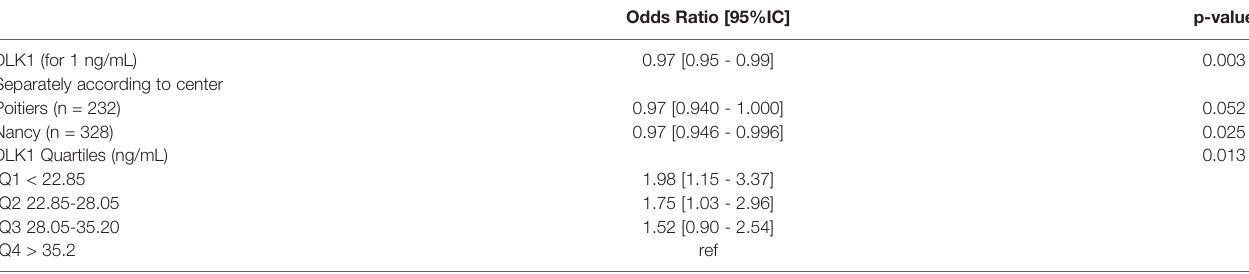
TABLE 3 | Multivariable logistic regression analyses of DLK1 as a predictor of risk of SGA (N = 560).